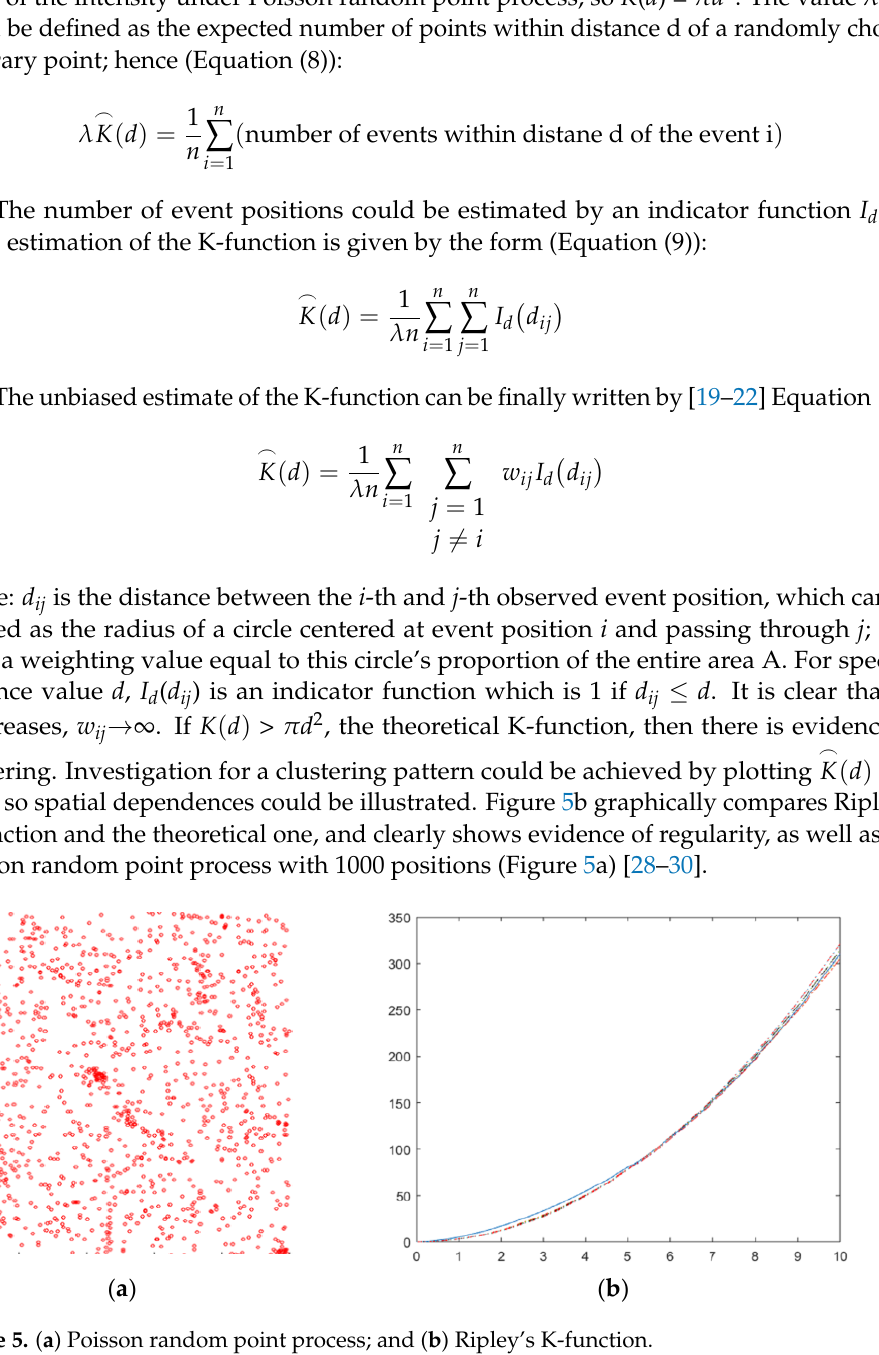
(cid:26) (cid:95) (cid:27) K ( d )